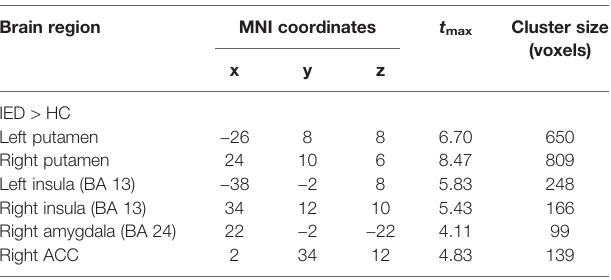
TABLE 4 | Functional magnetic resonance imaging (fMRI) results from analysis of covariance. Brain